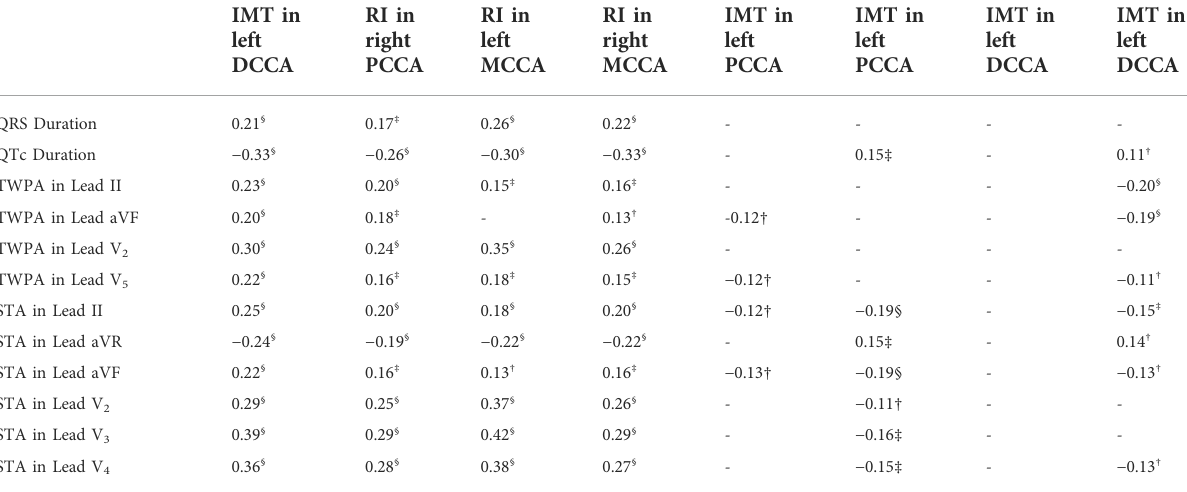
TABLE 4 Spearman correlations between ECG parameters and CUS parameters.